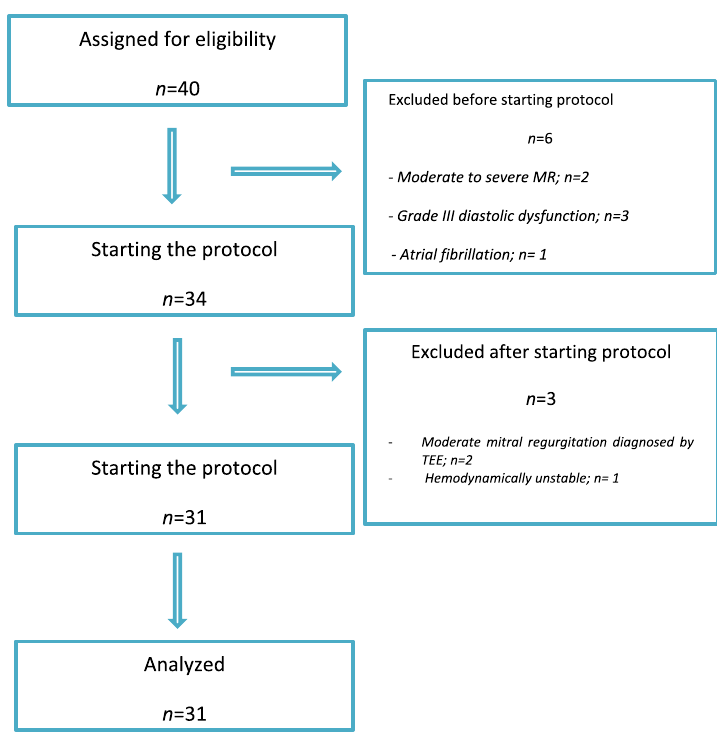
Table 1 Demographic characteristics among the studied cases